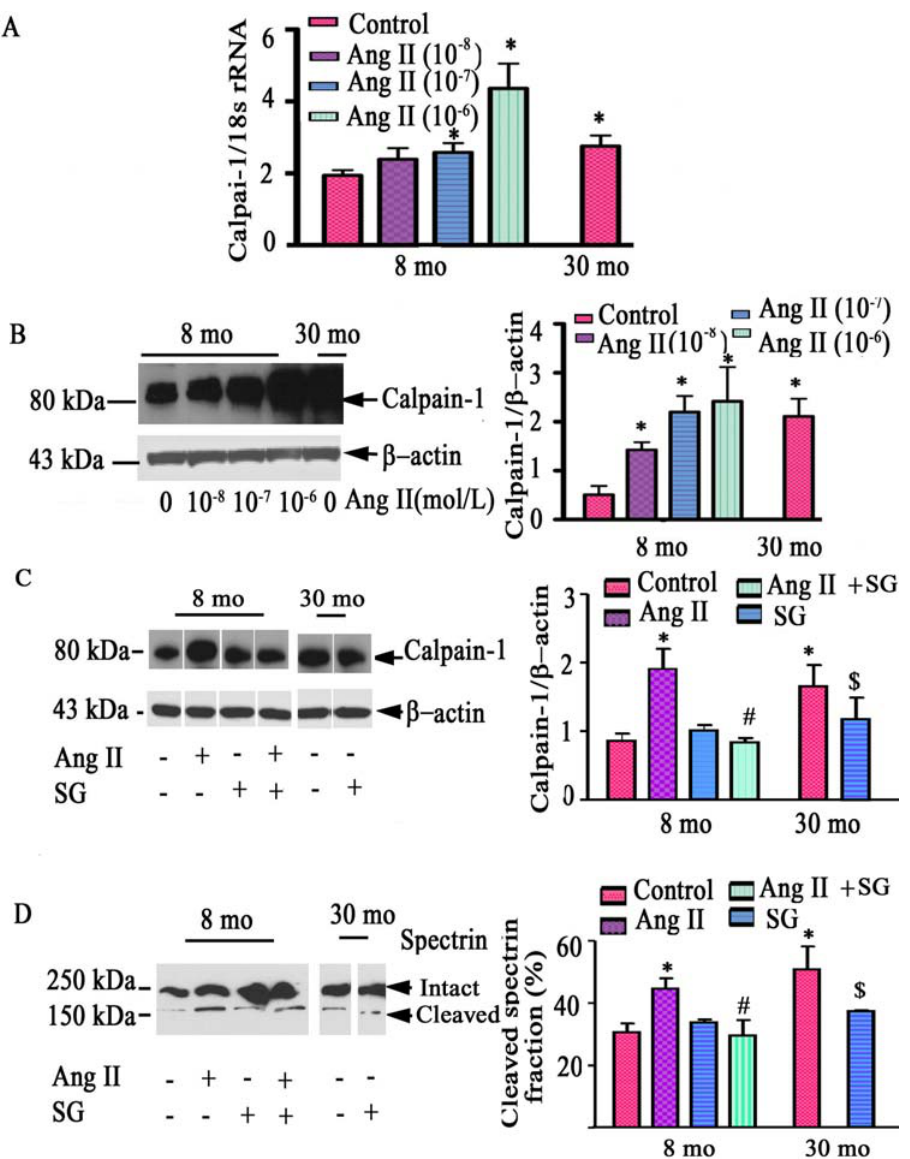
Figure 4. Calpain-1 induction in vitro by Ang II. A. Average calpain-1 transcript abundance from VSMC treated with Ang II for 48 hrs, determined by real time RT-PCR. B. Western blots of calpain-1 of early passage VSMC treated with Ang II for 48 hrs (left panels); average data (right panel). C . Western blots of calpain-1 of early passage VSMC treated with Ang II (10 2 7 mol/L) and or SG (10 2 7 mol/L), an AT1 antagonist, for 48 hrs (left panels); average data (right panel). D . Western blots of a -II spectrin of early passage VSMC treated with Ang II (10 2 7 mol/L) and or SG (10 2 7 mol/L), an AT1 antagonist, for 48 hrs (left panels); average data (right panel). *p , 0.05, vs. young untreated VSMC (control). # p , 0.05, vs. Ang II treated young VSMC. $p , 0.05, vs. old untreated